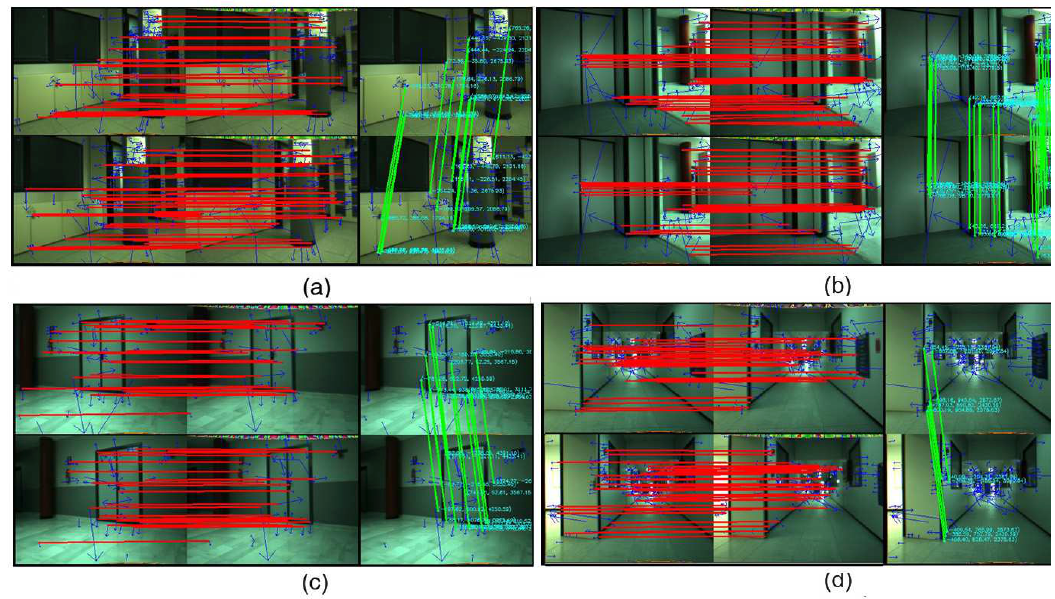
Figure 12. (a–d) Four different image pairs acquired by the stereo camera across the robot motion in the second reported trial. Stereo and feature matching are shown in the figure (red and green line,